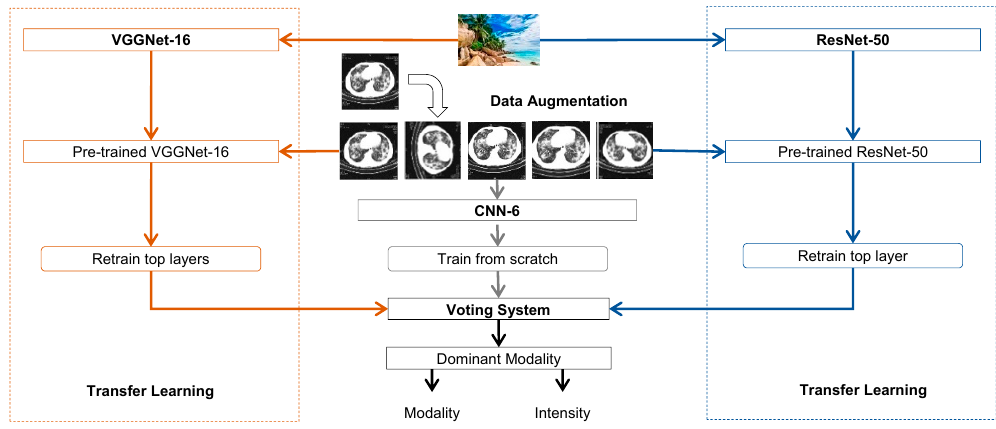
Figure 1. Architecture of our proposed model for subfigure classification. Deep CNNs are denoted as “network name-(depth)”.